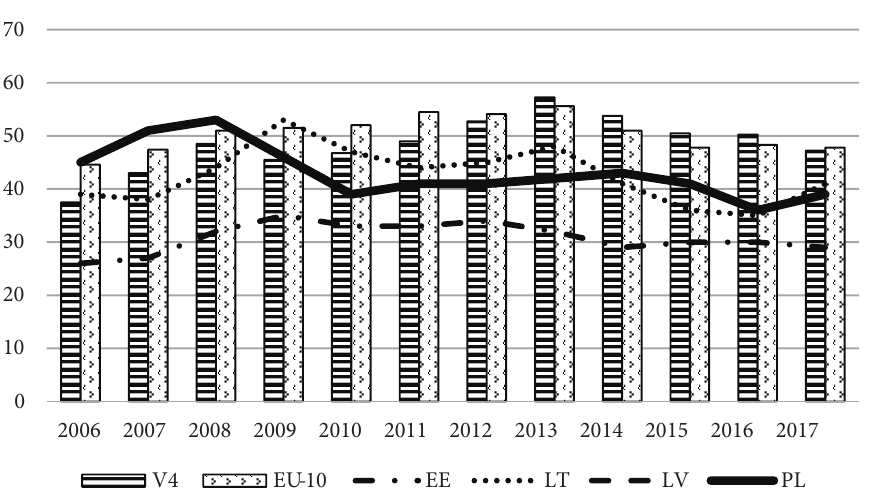
Figure 1. Competitive positions of the Baltic States against the backdrop of Poland, the V4 countries and the EU-10 in 2006–2017 (source: own study based on data as in Table 4)